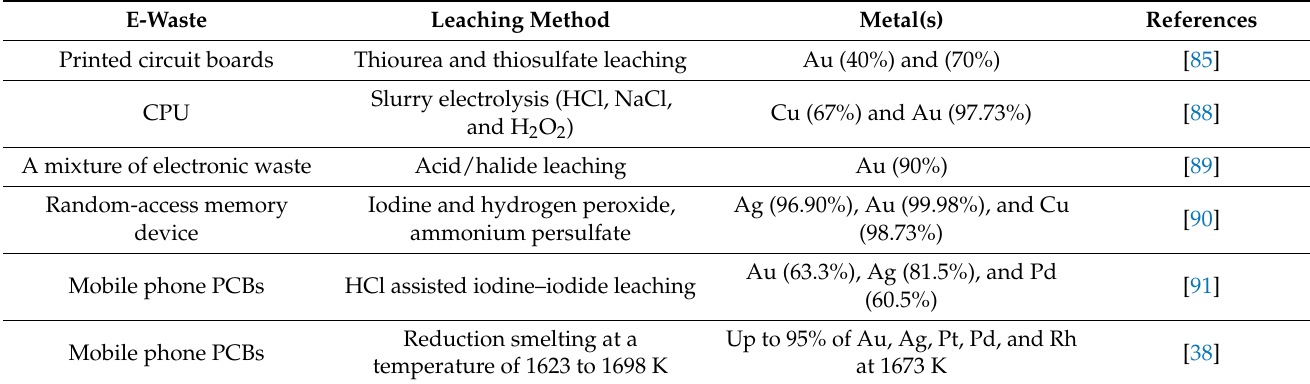
Figure 9. A hydrometallurgy method for recovering precious metals from e-waste [69]. Table 7. Different leaching reagents and recovery yields.